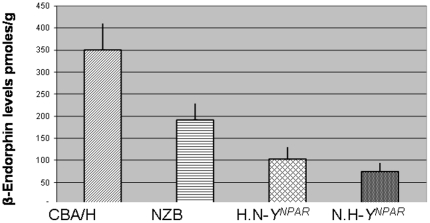
Brain BE concentration (mean ±SEM) in NZB and CBA/H and their consomic strains for YNPAR.The N.H-YNPAR differs only from the NZB by the YNPAR from CBA/H, and the H.N- YNPAR differs only from the CBA/H by the YNPAR from NZB. Partial comparisons with Student's t test showed that the parental NZB and CBA/H strains differed significantly (P<0.05), and each parental strain differed significantly from its consomic strain (CBA/H vs.H.N-YNPAR: P<0.001; NZB vs. N.H-YNPAR: P<0.01); n = 5 animals for each strain, except for NZB (n = 6); SEM = standard error of the mean.